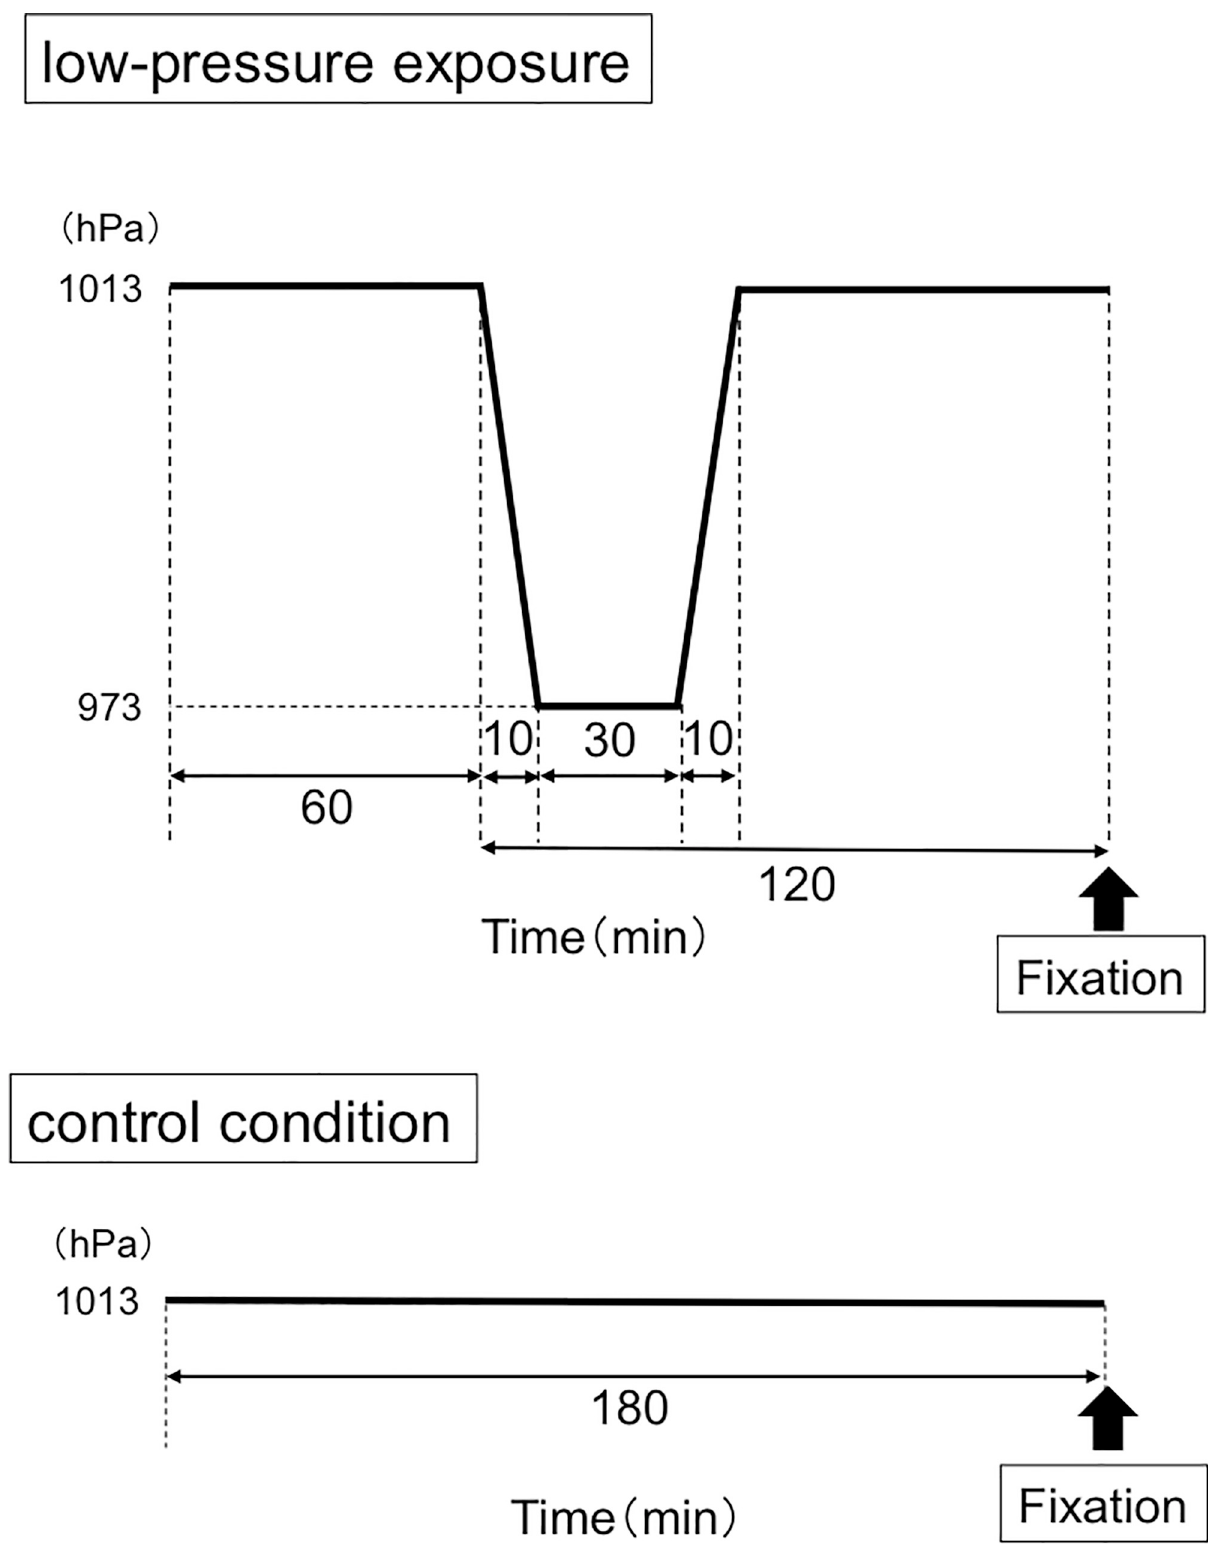
Fig 1. Time schedule of low-pressure exposure (upper panel) and control condition (lower panel). Barometric pressure was lowered from 1013 hPa to 973 hPa.